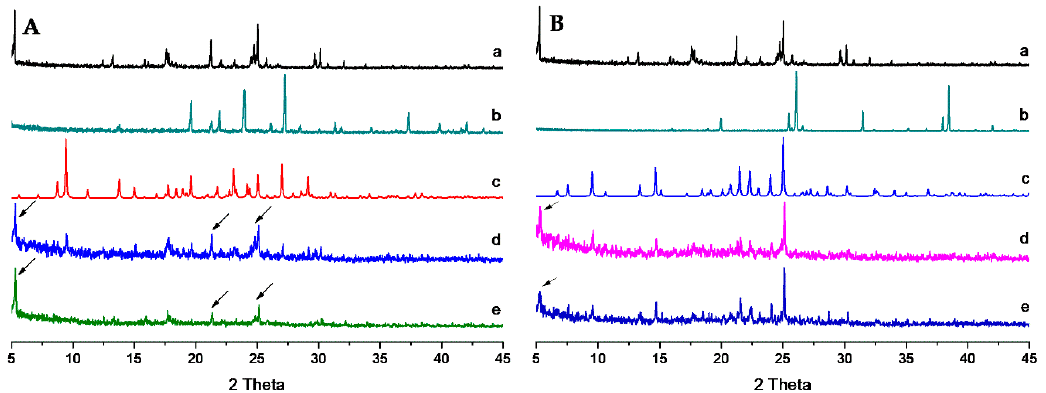
Figure 3. Comparison of powder X-ray diffraction (PXRD) patterns: A. (a) NTZ, (b) GLU, (c) NTZ-GLU simulated from SCXRD data. Solids recovered after powder dissolution tests of NTZ-GLU under non-sink conditions in pH 7.5 phosphate buffer solution after (d) 2 min, and, (e) 5 min. B. (a) NTZ, (b) SUC, (c) NTZ-SUC simulated from SCXRD data. Solids recovered after powder dissolution tests of NTZ-SUC under supersaturated conditions in pH 7.5 phosphate buffer solution after (d) 1 min, and (e) 3 min.